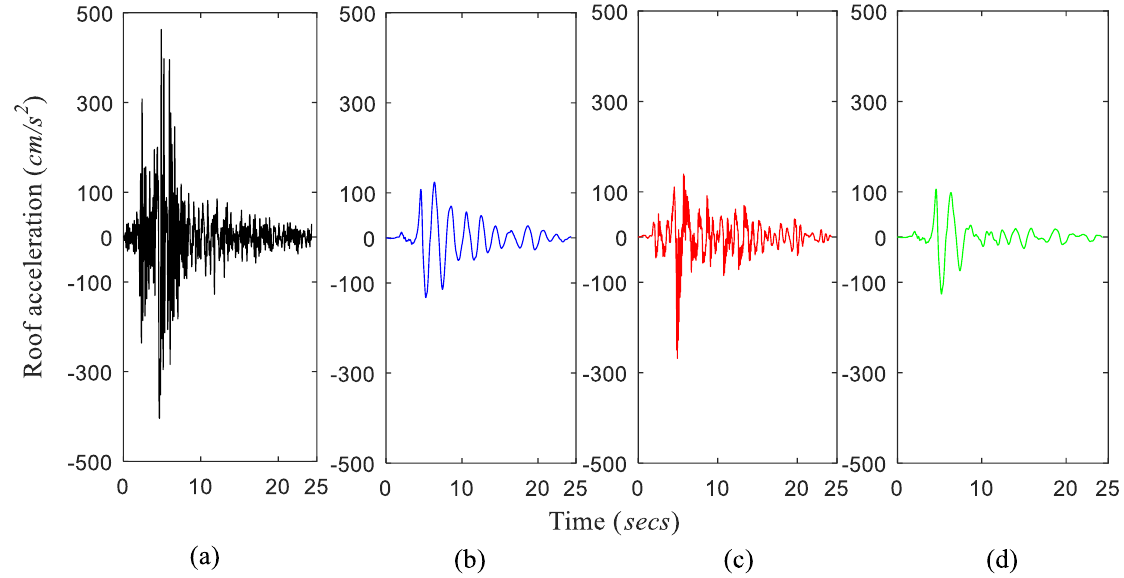
Fig. 10. Time history of roof absolute acceleration of (a) Fixed base (b) Isolated base with LRB (c) Isolated base with LPB (d) Isolated base with LRB and TMD structures under Chamoli earthquake.  The peak absolute acceleration of 5 th floor of isolated structure with LRB decrease by 98.93%, 95.29%, 94.76%, 97.77%, 71.35%, 79.7% and increase by 39.8 times and for isolated structure with LPB decrease by 92.93%, 86.53%, 76.11%, 83.09%, 41.99%, 51.98% and increase by 2.68 times under NE-India, India-Bangladesh Border, Uttarkashi, India- Burma Border, Chamoli, Bhuj earthquakes and wind load when comparing with fixed